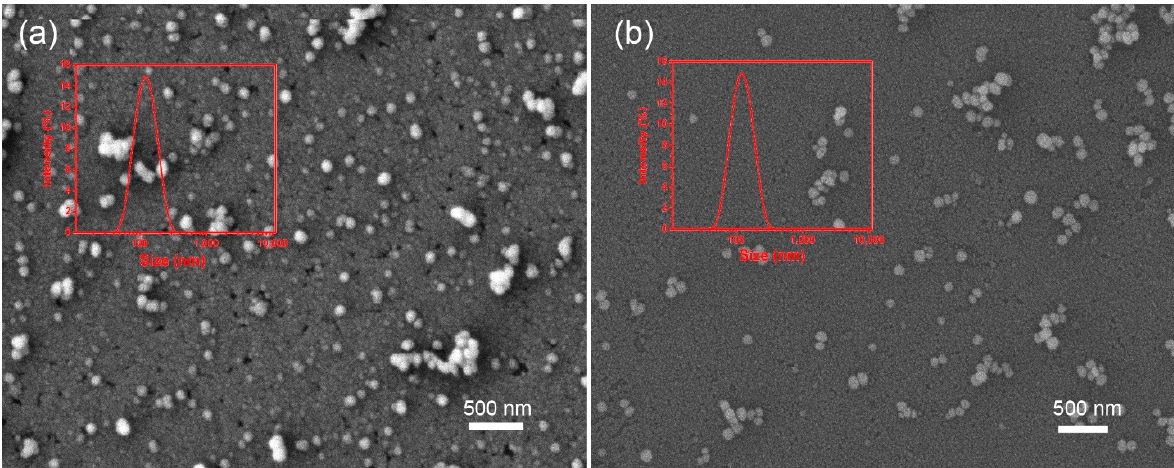
Figure 7. The DLS and SEM characterization of BNPs released from dilute acid and ultrasonic system. ( a ) BNPs released from dilute acid, ( b ) BNPs released from ultrasonic systems.